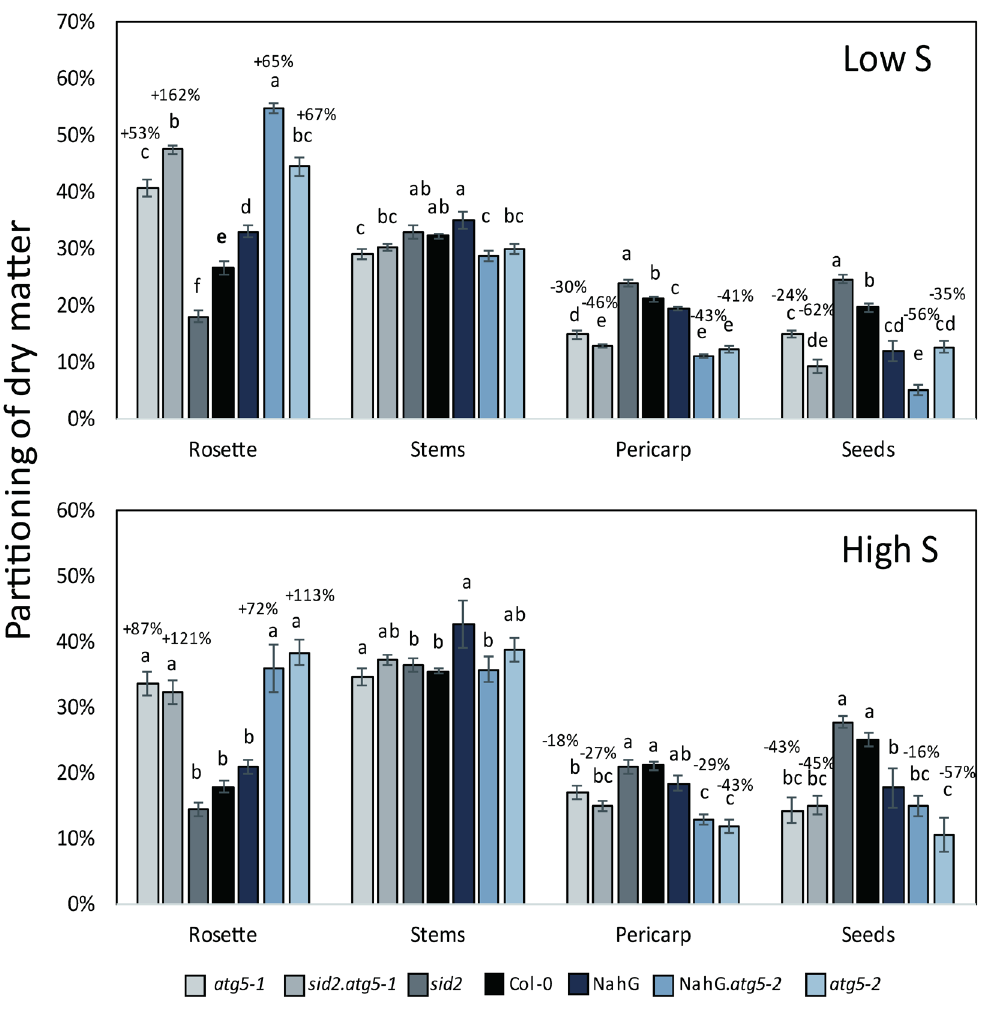
Figure 2. The atg5 autophagy mutants display a lower harvest index than the control lines under both low S and high S. From the measurement of the dry weights of the rosette, stem, pericarp and seeds presented in Figure 1A, the partitioning of the dry matter in each organ was computed. The numbers above the atg5 mutant bars indicate the % of significant increase or decrease in each mutant relative to its respective control line. Data are the adjusted means and SD from two biological repeats with six plants each. The di ff erent letters indicate values significantly di ff erent at p < 0.05 (n = 12), as determined using an ANOVA Newman–Keuls (SNK)